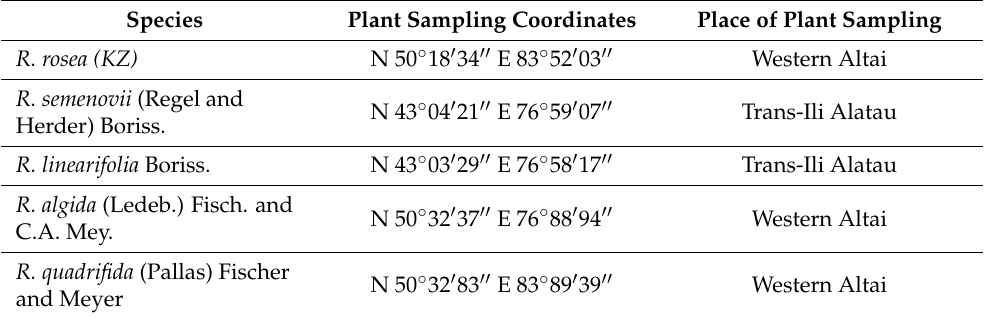
Table 4. Plant material used in this study. Species Plant Sampling Coordinates